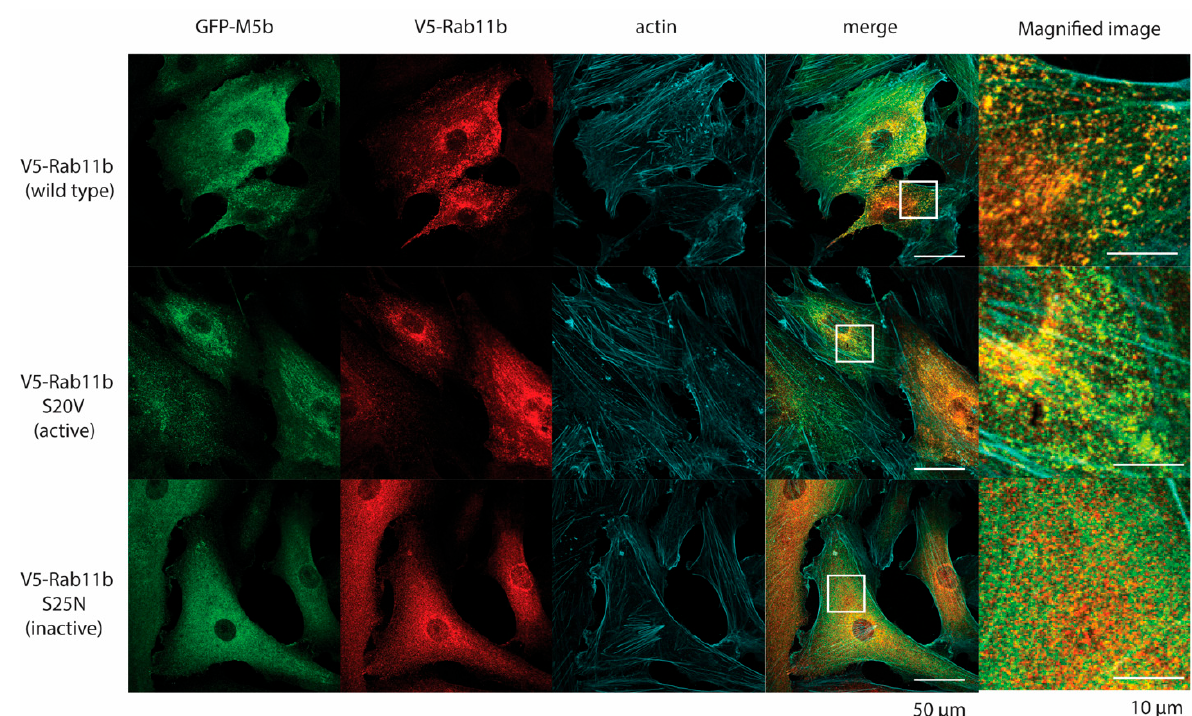
Figure 9. Effect of Rab11b activation on colocalization of Rab11b with Myo5b. Confocal images of localization of GFP- Myo5b and V5-Rab11b variants in HPMCs. GFP- Myo5b was expressed with v5-Rab11b (wild type), v5-Rab11b-S20V (active mutant) and v5-Rab11b-S25N (inactive mutant), respectively. After fixation, the cells were stained with anti-GFP- and anti-v5-antibodies, respectively. Magnified images of the boxed area are shown in the right. Note that the inactive variant showed diffuse localization. Representative images of n = 6 cells for each Rab11b constructs.